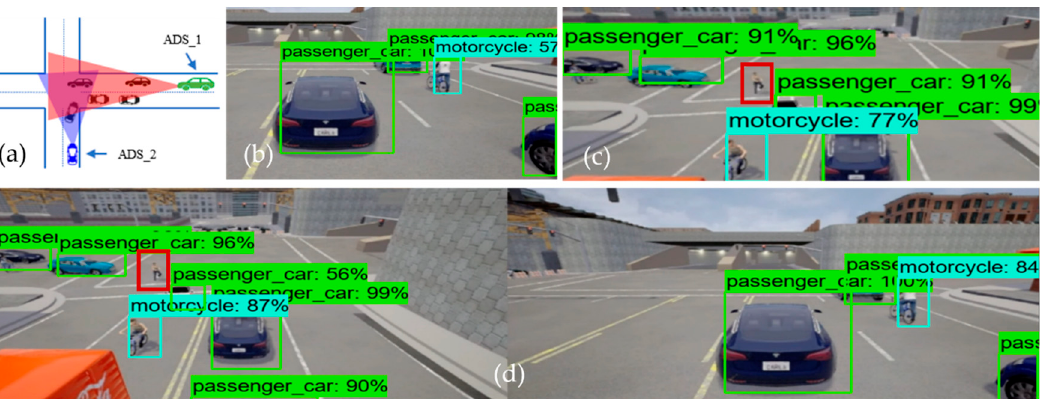
Figure 4. Top-level performance analysis of individual perception system of ADS_1 (receiver), ADS_2 (sender), and collaborative perception of ADS_1 at an intersection scenario. ( a ) represents an intersection scenario driving scenario, ( b ) represents the perception of ADS_1, ( c ) represents the perception of ADS_2, and ( d ) represents the collaborative perception of ADS_1.